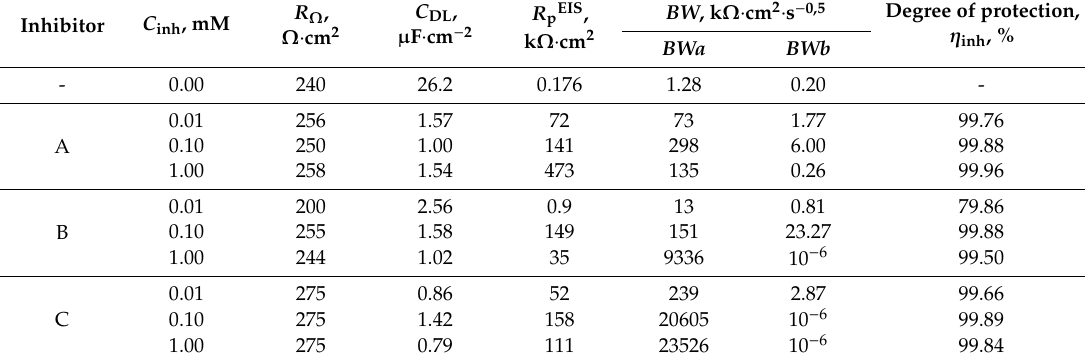
Table 5. Equivalent circuit elements and degree of protection of brass electrode in 10 mM NaCl solutions with various derivatives of 5-amino-1 H -1,2,4-triazole.